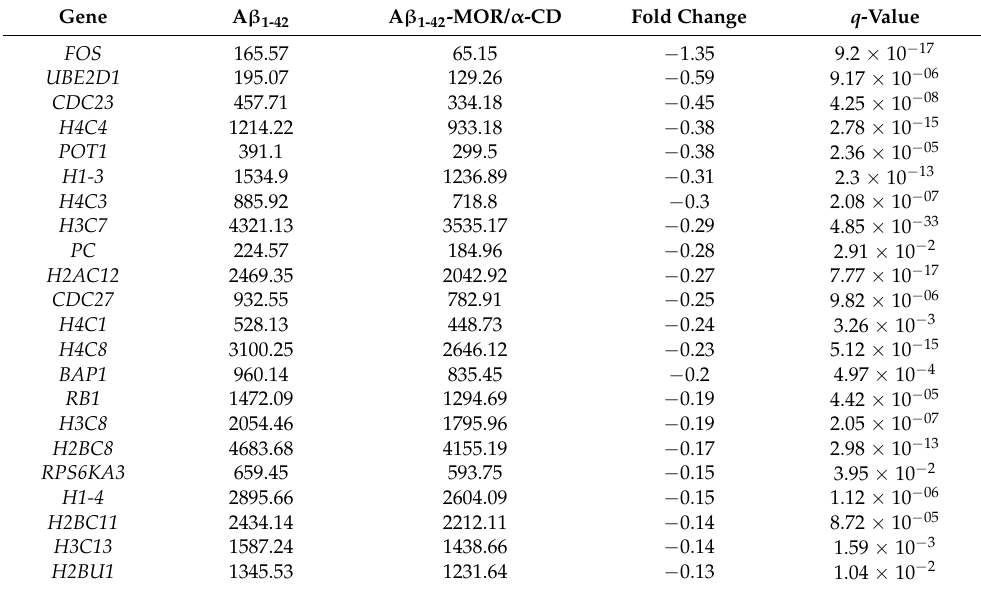
Table 1. Differentially expressed genes exclusively enriched in “Cellular Death”, “Cellular Repair” Table 2. Differentially expressed genes exclusively enriched in “Cellular Death” and “Autophagy” groups simultaneously.